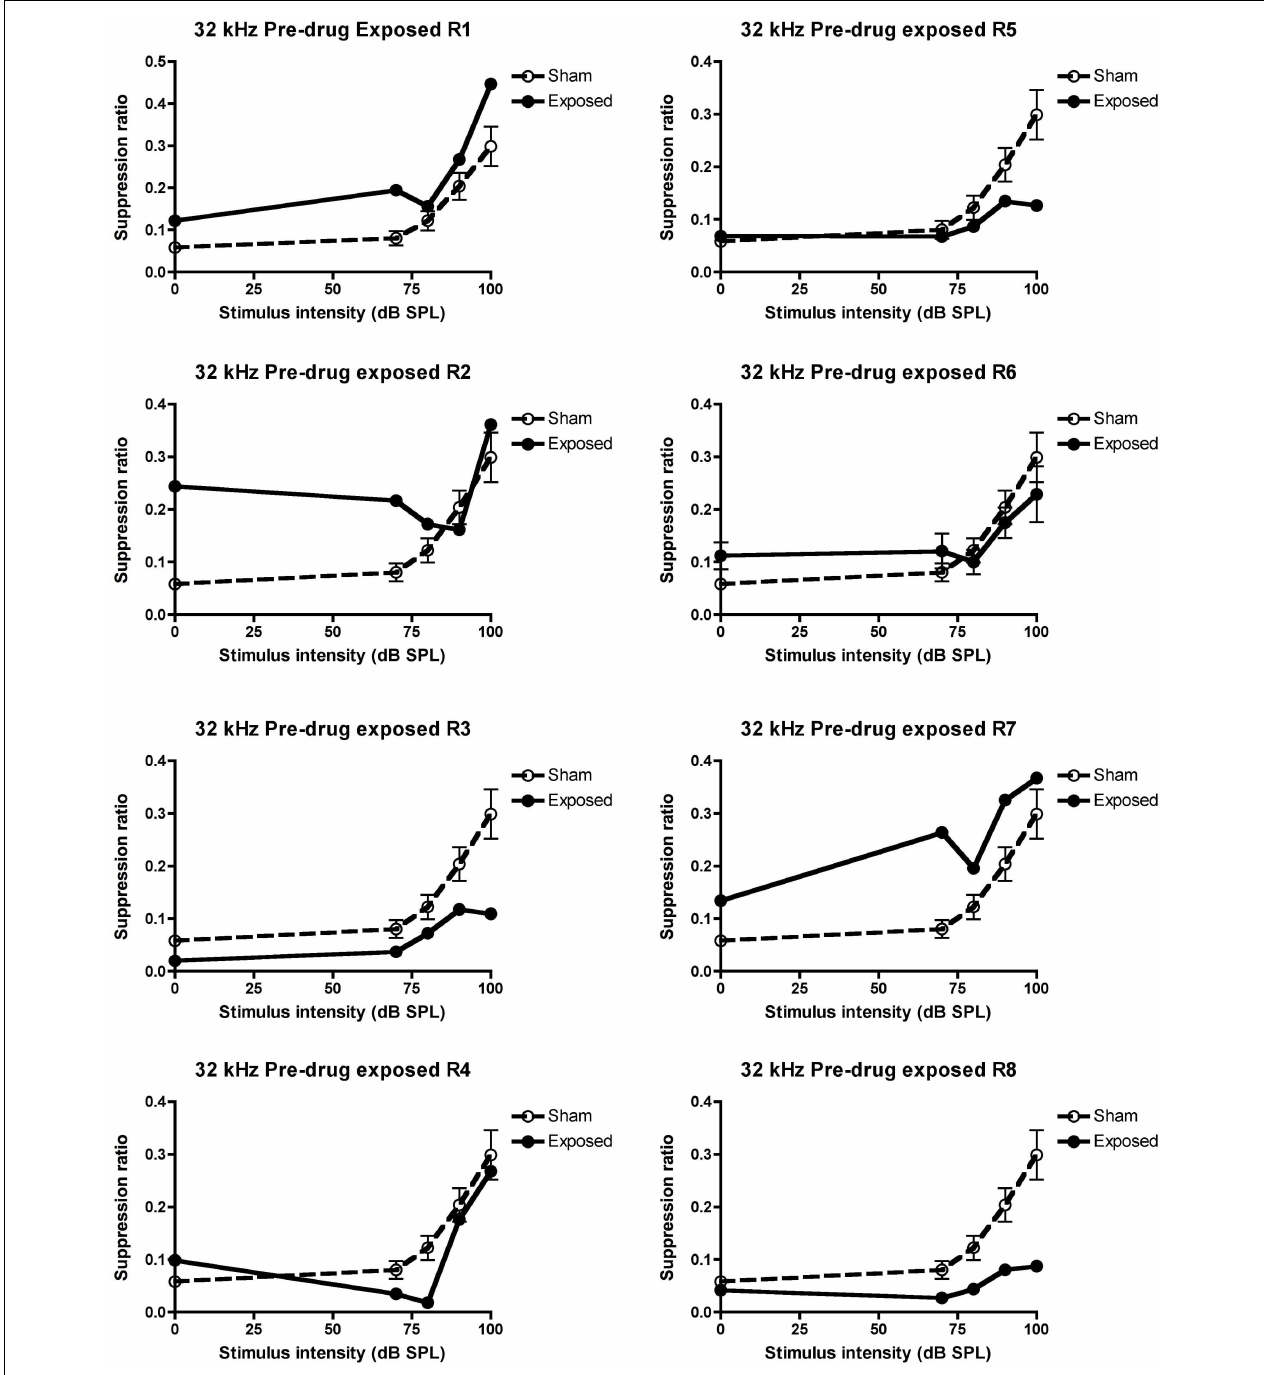
FIGURE 3 | Suppression ratios for the individual acoustic trauma-exposed animals plotted against the mean SRs of the sham control animals before any drug or vehicle administration, as a